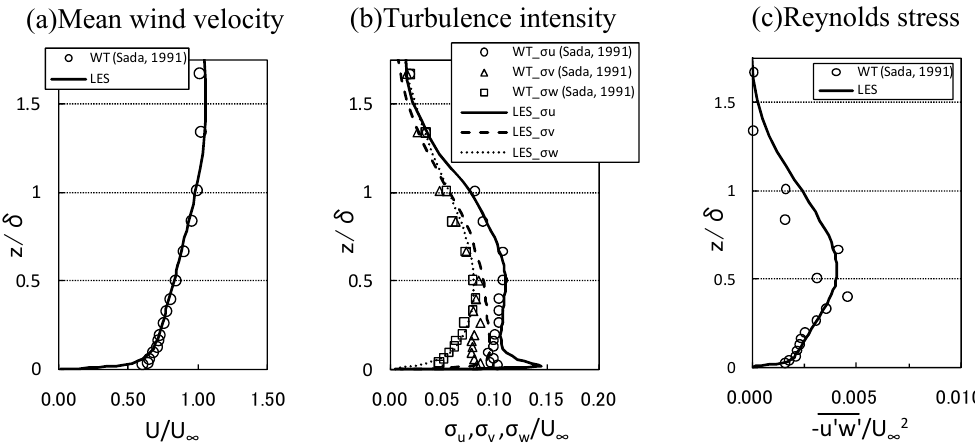
Fig. 1. Schematic illustration of computational model. (a)Driver region for generation of a spatially-developing TBL flow and (b)main region for plume dispersion over hill.